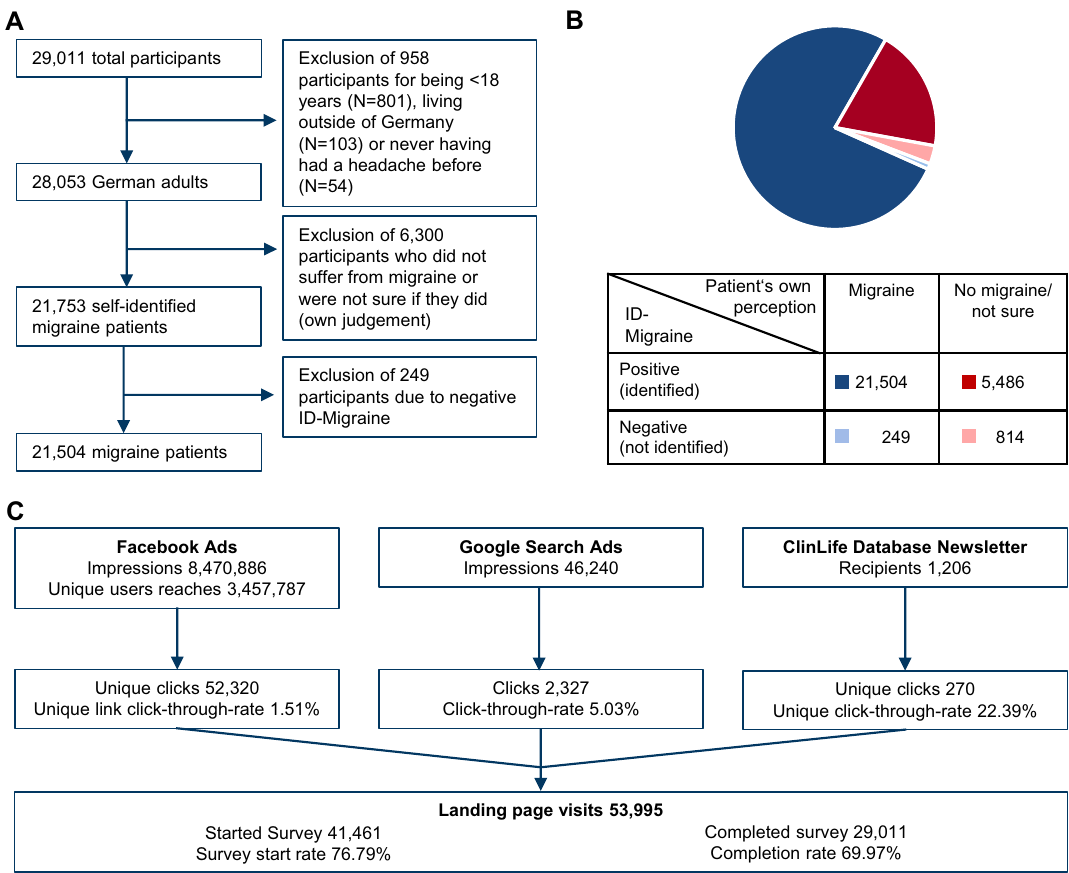
Figure 1. Description of survey participants. ( a ) Flowchart specifying the inclusion criteria of the survey. Taken together, 21,504 participants fit the criteria and will hereafter be referenced as “migraine patients”. ( b ) Graph showing disease awareness of survey participants. All German participants (N = 28,053) were categorised into aware of their migraine (N = 21,753, blues) vs. not aware/not sure (N = 6,300, reds) based on their own judgement. Assumptions were then confirmed via the ID Migraine screener. The screening was positive, and the patient was identified as a migraine patient if at least two out of three questions were affirmed (Supplementary Table S1). ( c ) Overview of the total view/click-through sample “n” and rate, participation “n” and rate, and completion “n” and rate for the different adverting